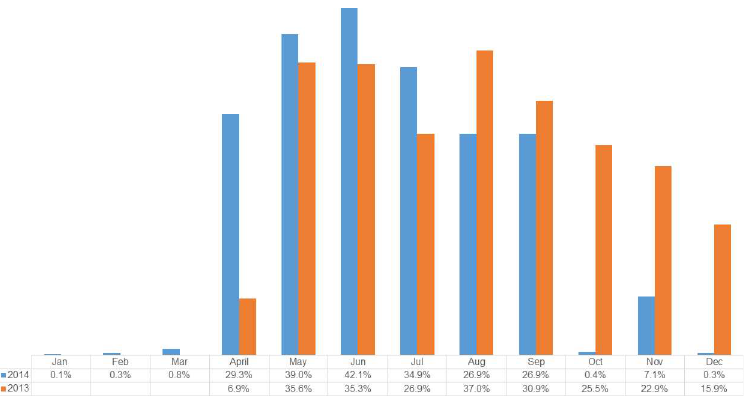
Fig 5. Percentage of mothers reached with misoprostol, based on monthly expectednumber of births, in Sokoto State between April 2013 and December2013 and in 2014 in Sokoto State, Nigeria, by